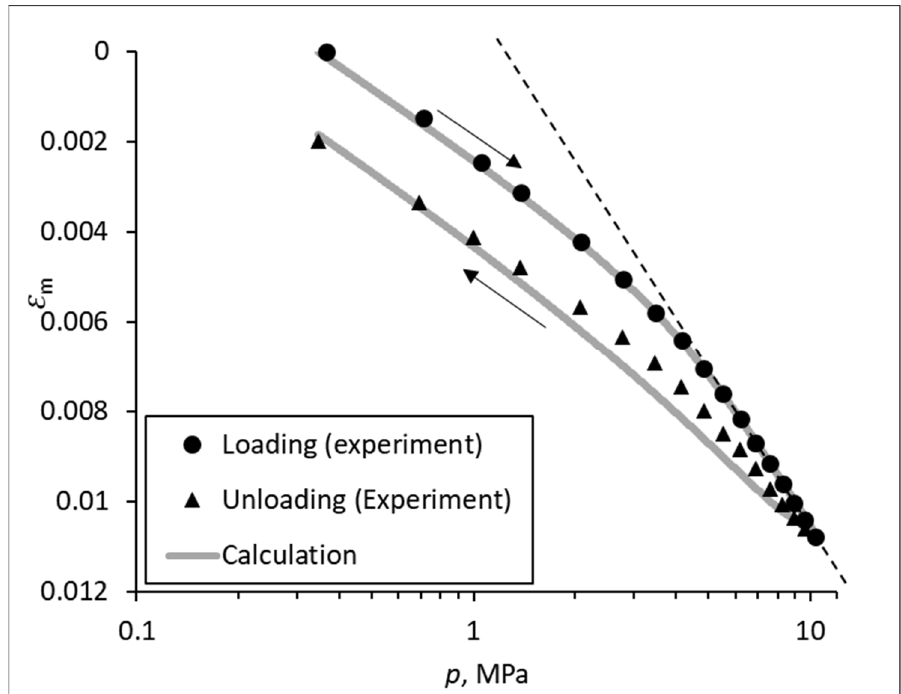
Figure 6. Strain–stress path of coal sample 2 in a stress cycle.